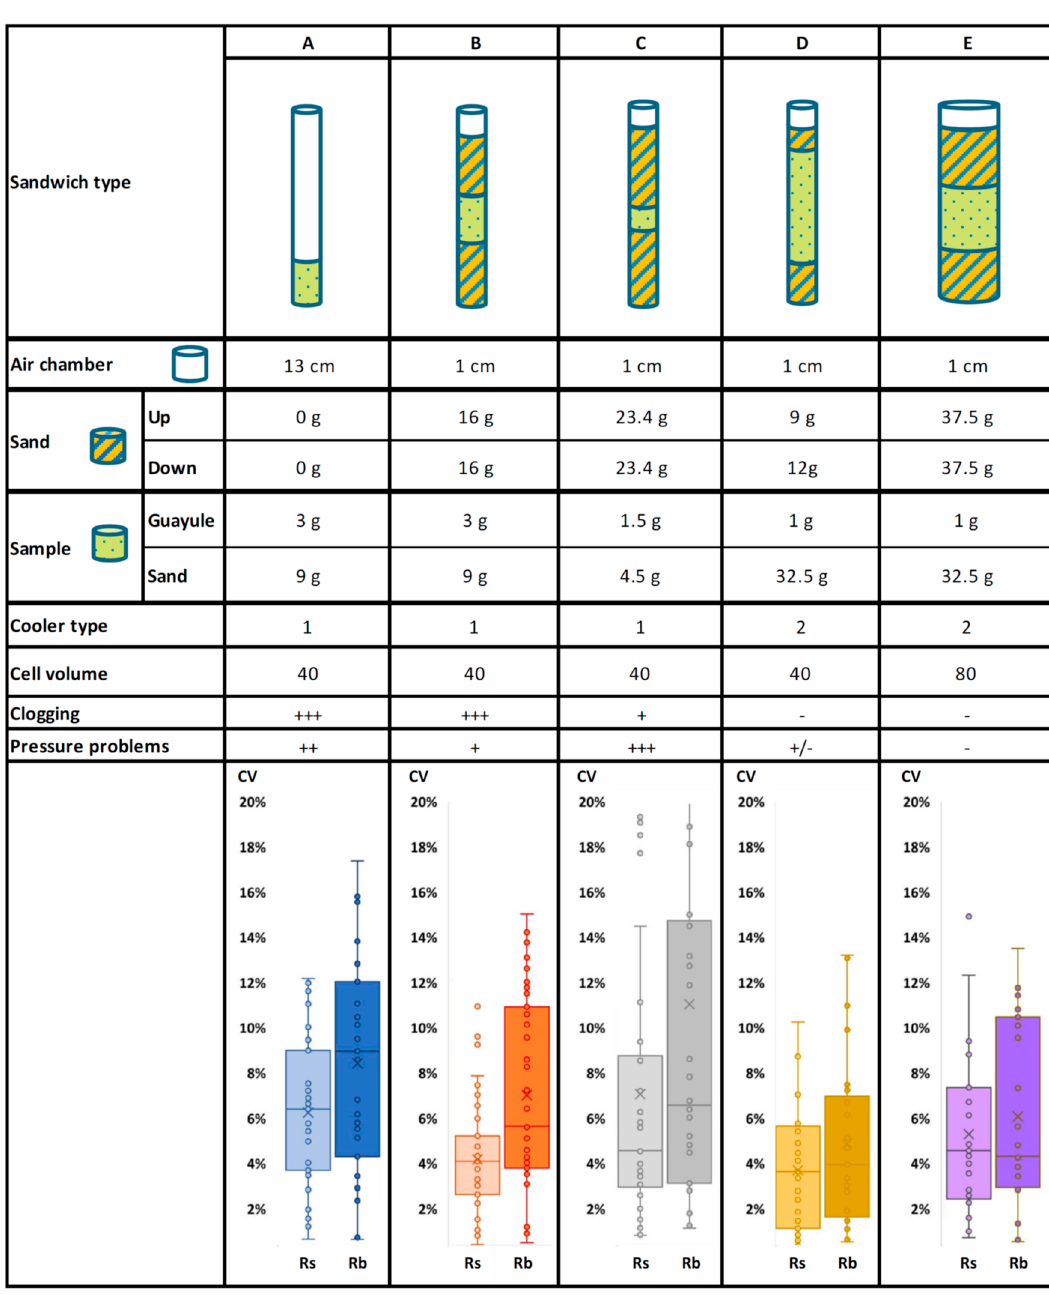
Figure 1. Overall design of the testing conditions and the coefficients of variation (CV) for resin (Rs) and rubber (Rb) extractions from 30 guayule samples extracted by BÜCHI accelerated solvent extraction (BASE) using five different sample preparation processes ( A – E ). The fixed parameters for resin were acetone as solvent, 3 cycles of 20 min at 40 °C and 100 bar and for rubber, hexane as solvent, 3 cycles of 20 min at 120 °C and 100 bar. Pressure and clogging problems are represented using a scale from +++ (the highest value, many problems) to—(the lower value or absence of problems).